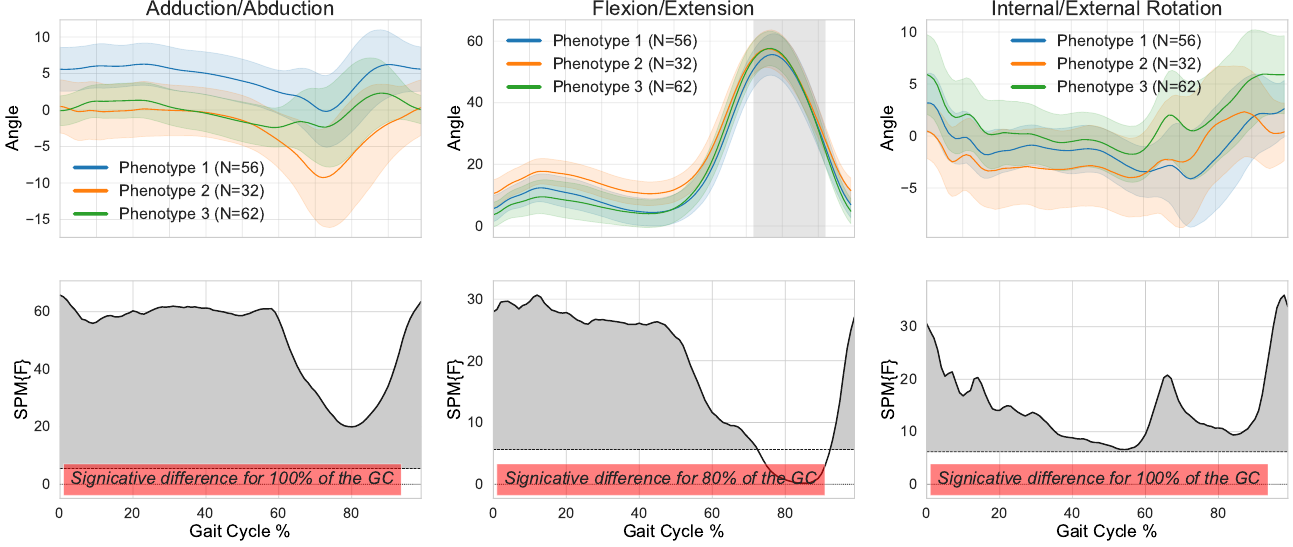
Figure 5. The three identified phenotypes based on local representation (Line 1) and the corresponding SPM{t} with a significance threshold α = 0.05 (Line 2). The gray area indicates the percentage of the gait cycle for which the three phenotypes are